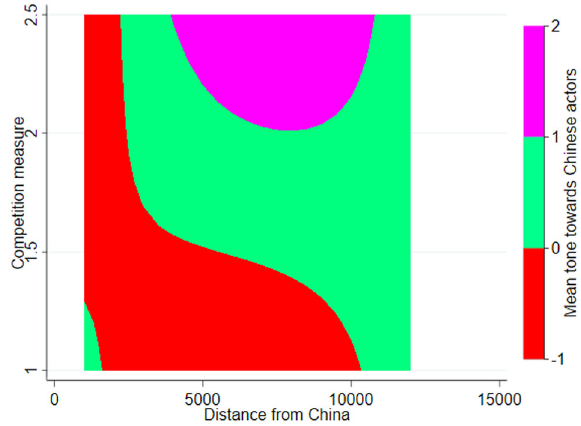
Fig. 6 Contour plot of predicted mean emotional tone taken by the local presses towards Chinese actors at the intersection of the Great Power Competition and tone taken towards Russian